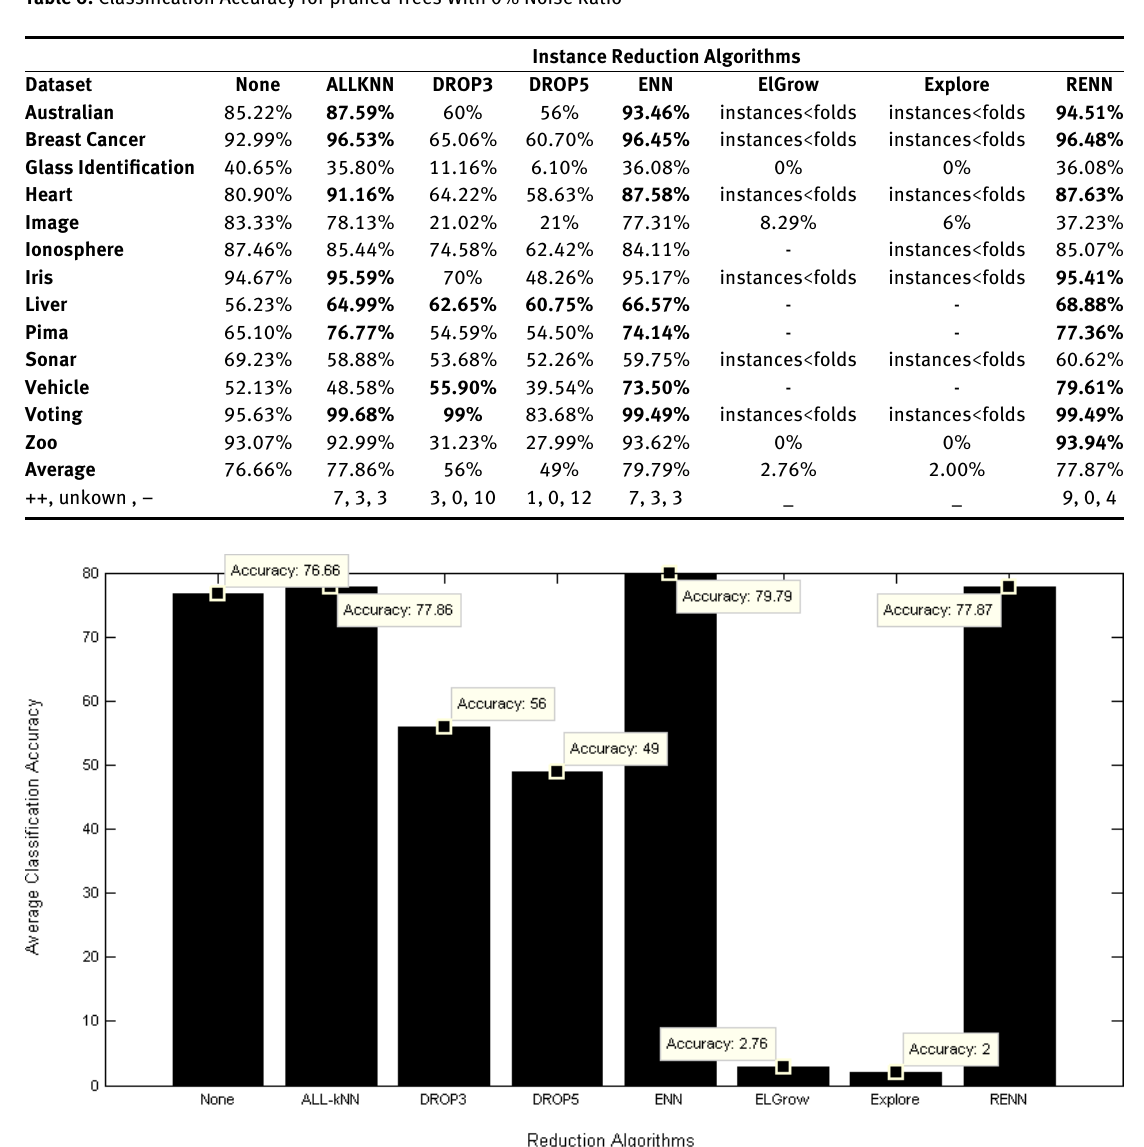
Table 6: Classification Accuracy for pruned Trees With 0% Noise Ratio